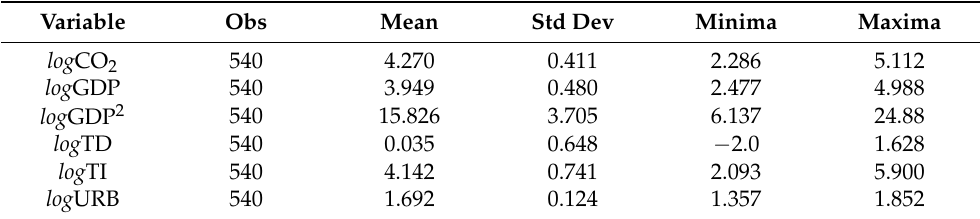
Table 2. Descriptive